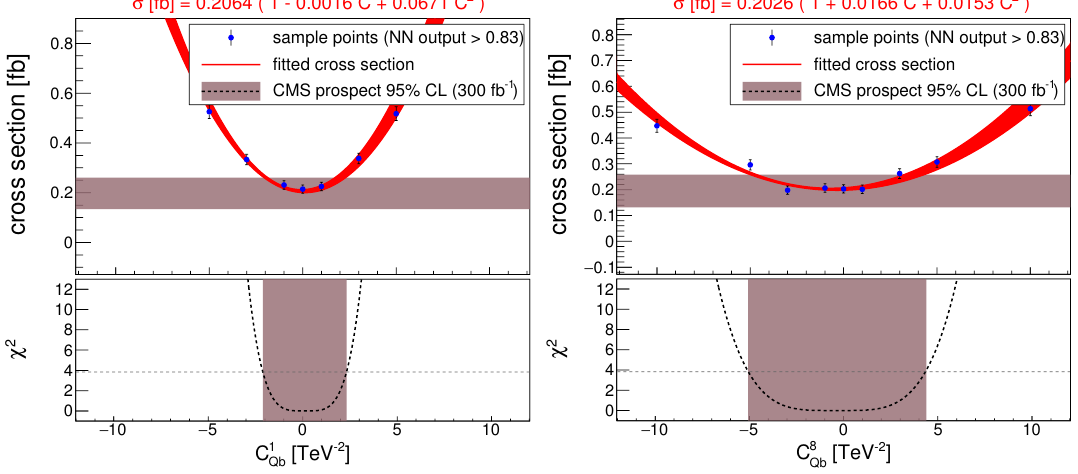
Figure 11 . Limits at 95% CL on C 1 be above 0.83 and assuming an integrated luminosity of 300 fb (cid:0) 1